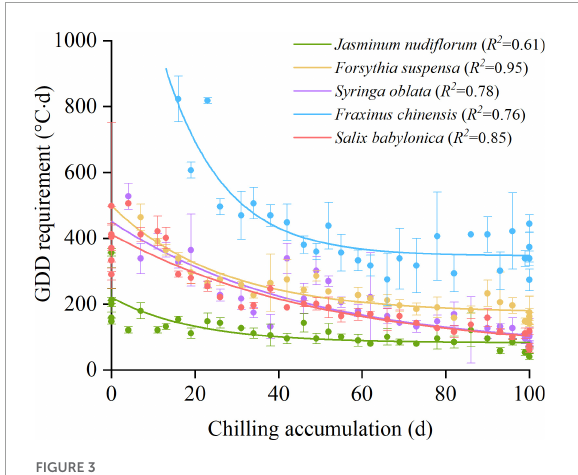
FIGURE3 Relationships between chilling accumulation and growing degree day requirements (GDD R ). Error bars: standard